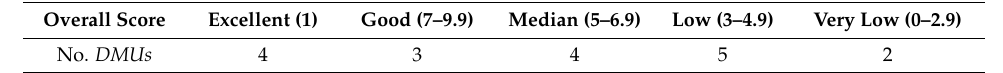
Table 3. Classification of overall